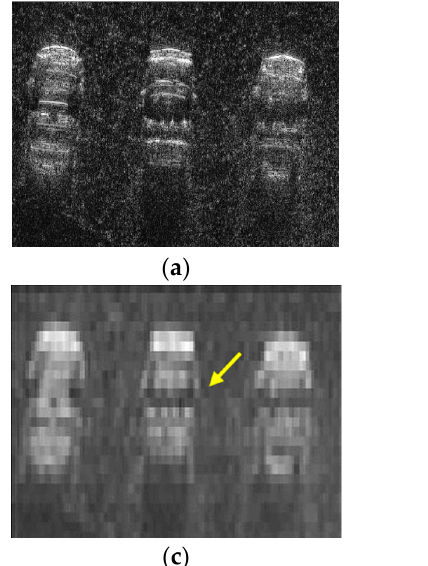
Figure 11. Multi-target simulations of the ( a ) scatterer distribution; ( b ) original single-track image; and ( c ) image processed by the azimuth super-resolution method.